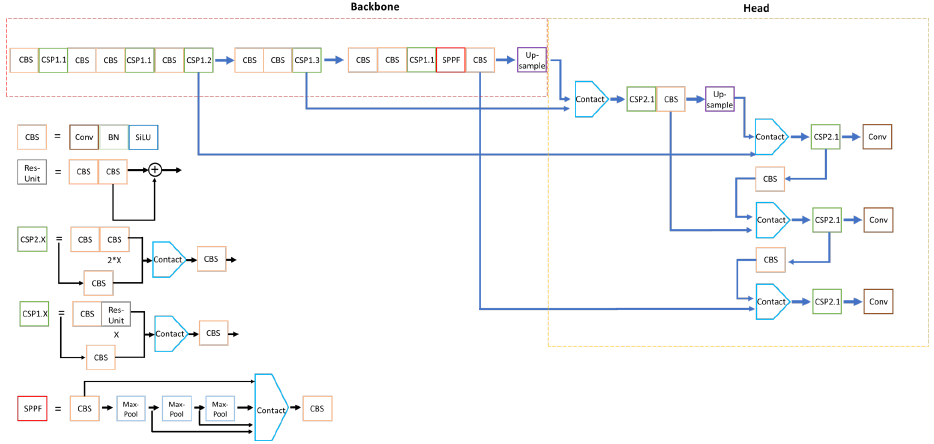
Figure 5. The structure of Improved